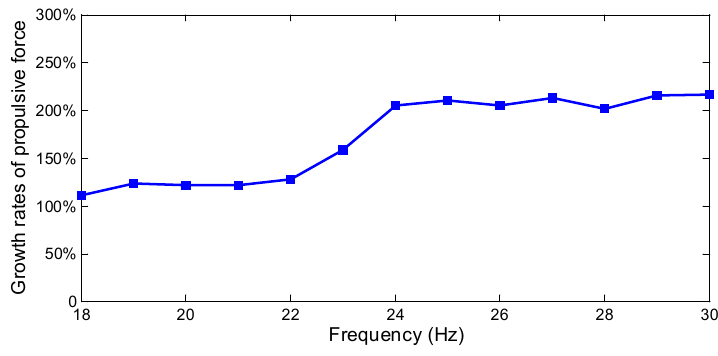
Figure 14. Growth rates of propulsive force.